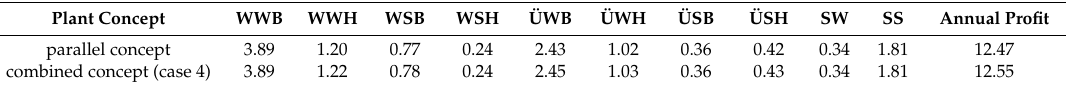
Table 8. Revenues for each typical day for pure electricity production and parallel heat extraction in million €